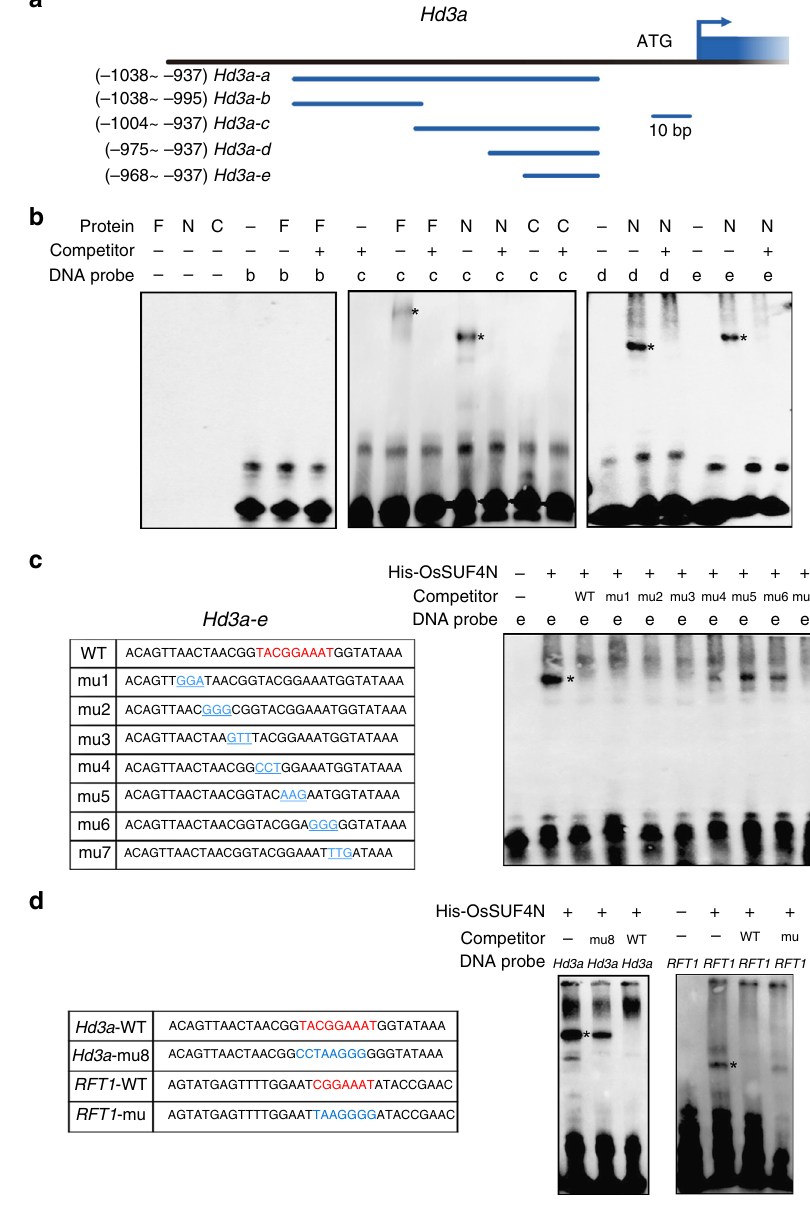
Fig. 5 OsSUF4 binds to a speci fi c 7-bp DNA element. a Schematic representation of the truncated Hd3a promoters. b Mapping the OsSUF4-binding site within the Hd3a promoter. Asterisks indicate the position of the shifted bands. F, N, and C represent the puri fi ed full-length, N-terminal, or C-terminal His-OsSUF4, respectively. DNA probe: Hd3a-b , Hd3a-c , Hd3a-d , and Hd3a-e . Competitors: unlabeled probes (100-fold excess). c Left panel: wild-type (WT) and mutated (mu) DNA probes corresponding to Hd3a-e (key element is highlighted in red and mutated bases are shown in blue). d EMSA analysis using mutations of the 9-bp element 5 ′ -TACGGAAAT-3 ′ within Hd3a-e and the 7-bp element 5 ′ -CGGAAAT-3 ′ within RFT1 . Source data are provided as a Source Data fi